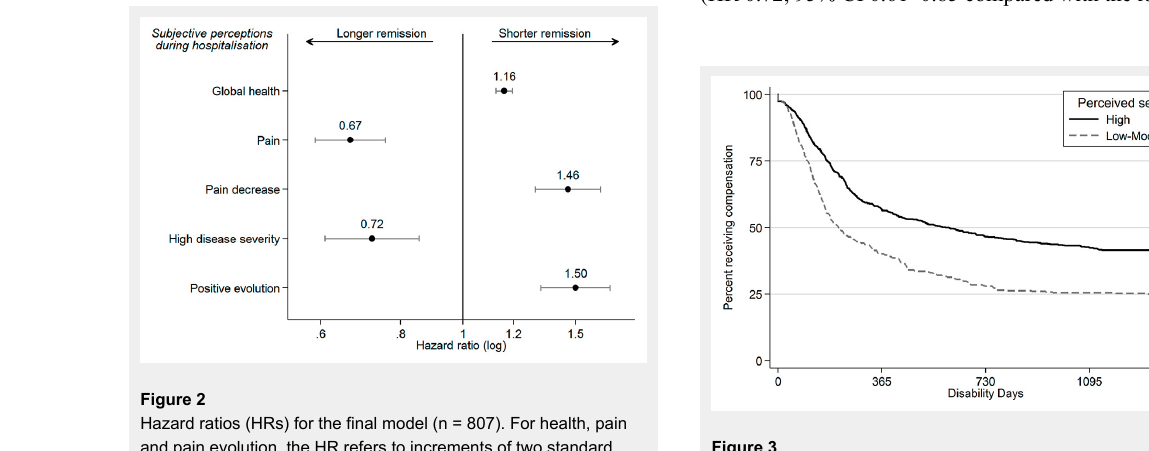
Figure 3 Survival functions according to the perceived severity of the